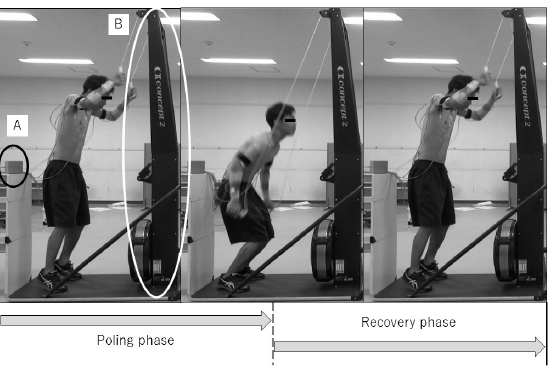
Figure 1. Measurement environment and phase division. ( A ) the transmitter of the electromagnetic tracking device; ( B ) the ski ergometer